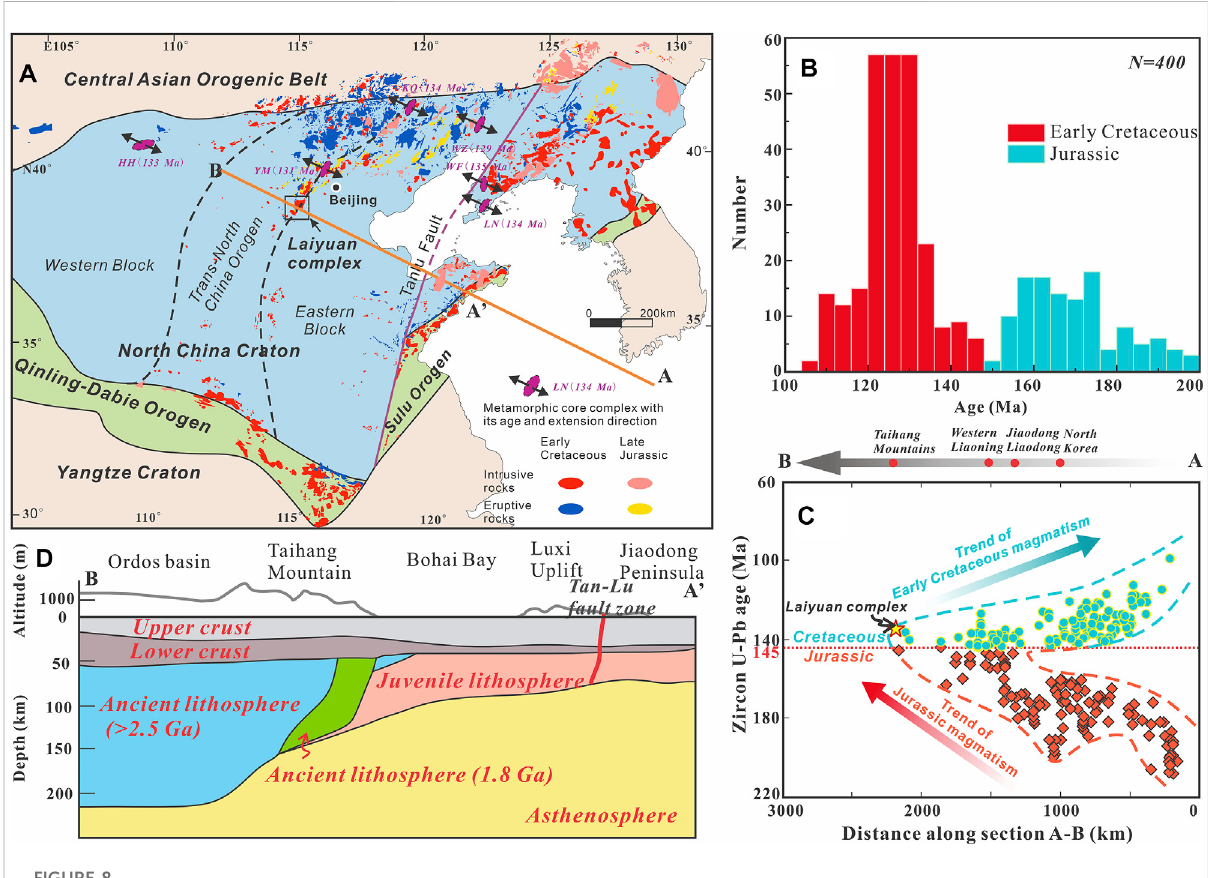
FIGURE 8 (A) Tectonic map of the North China Craton and surrounding regions showing the metamorphic core complex (modi fi ed after Zhu et al., 2015) and Early Cretaceous and Late Jurassic magmatic rocks (Zhao et al., 2005; Zhang et al., 2014). (B) Histogram of zircon U-Pb ages of Late Mesozoic igneous rocks in the NCC. (C) Projection of zircon U-Pb ages along section A-B (in Figure 8A) cross the NCC. The combinations of the zircon U-Pb ages are modi fi ed after Wu et al. (2019) and reference therein. (D) The schematic lithospheric structure of the current NCC from the eastern Jiaodong Peninsula through the central Taihang Mountain (A ′ -B in Figure 8A, not to scale) to the western Ordos Basin revealing the lithosphere heterogeneity beneath theNCC (modi fi ed afterLiuet al., 2019).Metamorphic corecomplex:KQ-Kalaqing metamorphic core complex;